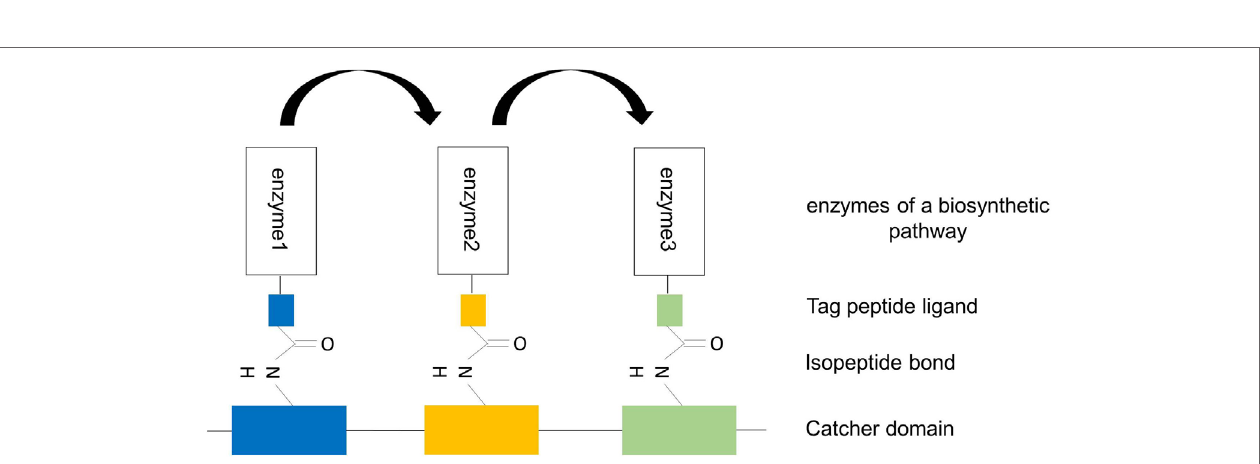
FiGURe 7 | Design of artificial trimeric proteins (functional trimer or even oligomers) by using different, covalent, alternative SpySystems . The scaffold consists of different unique Catcher domains and the enzymes to be co-localized are fused to the corresponding specific Tag domains. Thanks to the specific and covalent interaction between the Catcher domains and their Tag domains, the enzymes are irreversibly targeted and bound to the scaffold. The specificity of this system enables the precise control of the enzyme ratio and the exact position of the enzymes at the scaffold. Metabolic channeling (indicated by the arrows) should be possible because of the enforced proximity of the sequential pathway enzymes.